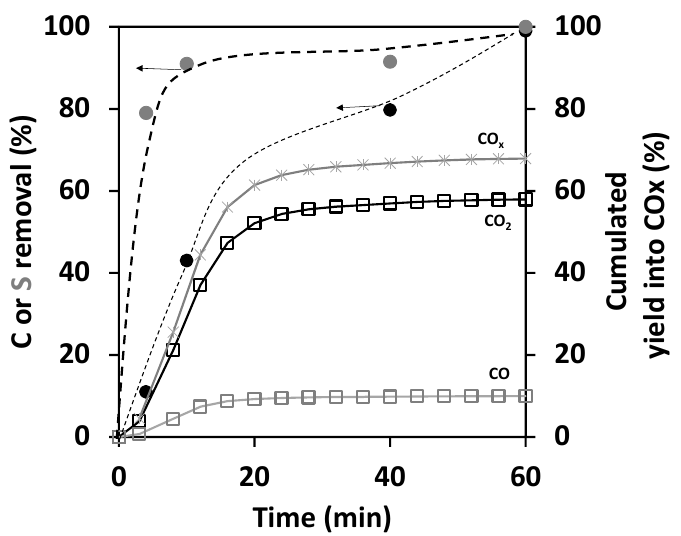
Figure 8. Time comparison of carbon ( ) and sulfur ( ) removal on the spent catalyst with the cumulated yields of CO ( ), CO 2 ( ), and their sum ( ). Experiments were performed at P = 7 W and 200 °C.